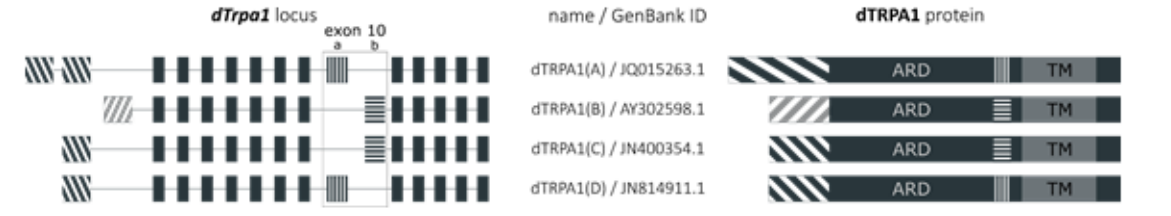
Figure 7. Schematic representation of dTRPA1 sequences and proteins. Diagram of the genomic locus of dTrpa1 ( left ) resulting in different isoforms of dTRPA1 proteins ( right ). In the middle: the nomenclature that we maintain and the corresponding GenBank reference. ARD = ankyrin repeat domains, TM = trans-membrane segments.